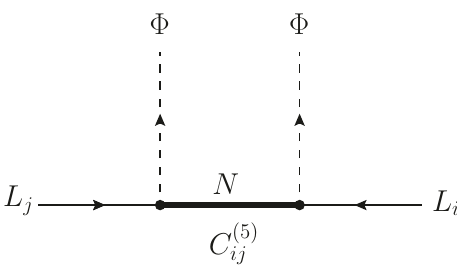
Figure 2. Feynman diagram in the type-I seesaw contributing to the Wilson coefficient of the Weinberg operator. In the inverse seesaw limit, the neutrino Yukawa matrices are chosen in such a way that this diagram vanishes and lepton number is